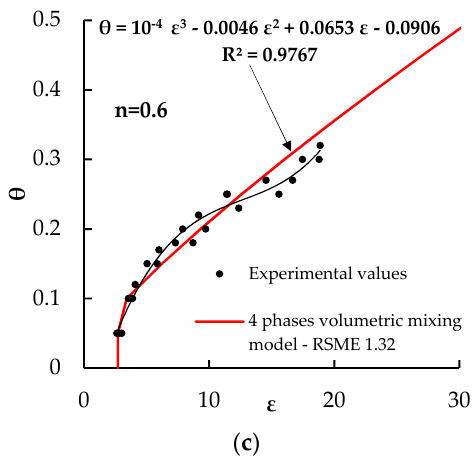
Figure 5. Fitting to the experimental data of the four-phase dielectric mixing model of Dasberg et al. [41], with calibrated parameters, for the various investigated porosities. ( a ) n = 0.5; ( b ) n = 0.55; ( c ) n = 0.6.